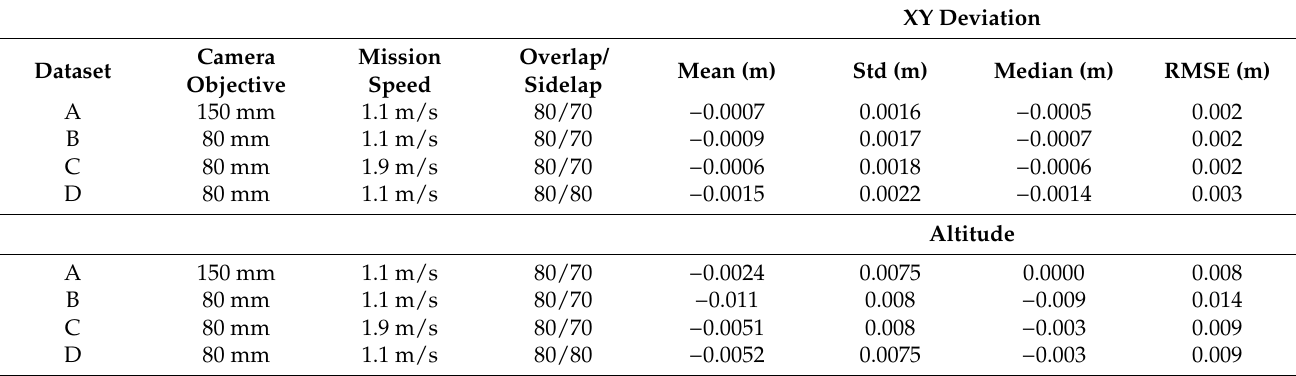
Table 5. Effect of different camera lens, speed and sidelap on the